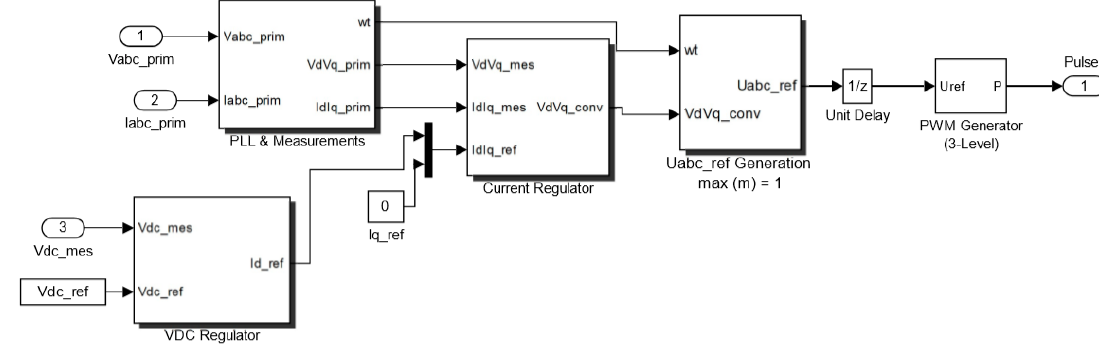
Figure 13. Inverter control loop modelling.